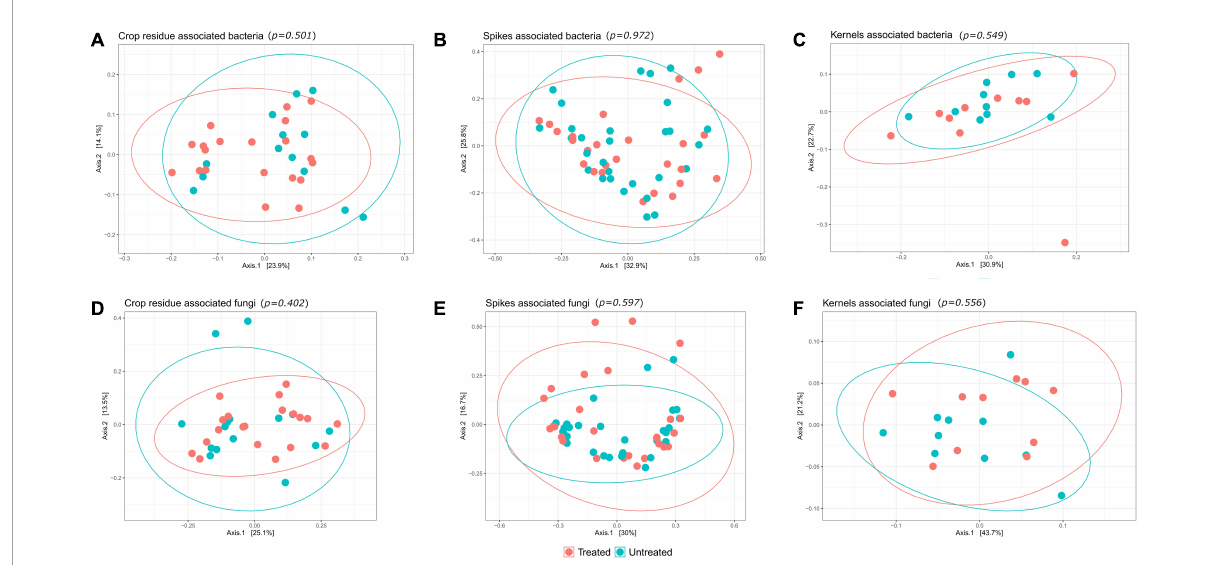
FIGURE5 Application of T6085 causes no broad changes in microbiomes of wheat. Plots are principal coordinates ordinations derived from pairwise community dissimilarity values (Bray-Curtis index). Panels represent bacterial communities from (A) crop residue; (B) wheat spikes; (C) wheat kernels; and fungal communities from (D) crop residue; (E) wheat spikes; (F) wheat kernels. Treatments have been grouped according to whether or not T. gamsii T6085 was applied to the tissue in question. Ellipses represent a 95% confidence level. The fungal and bacterial microbiomes did not show any significant community scale change due to T6085 treatment (Adonis test, p-values shown above each